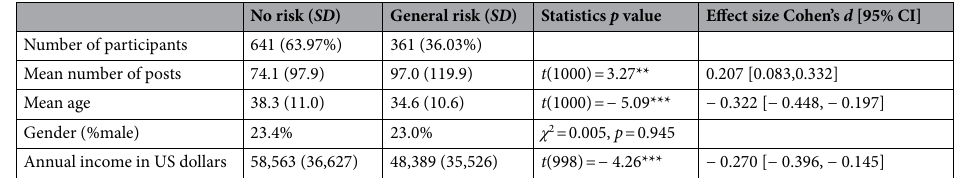
Table 2. Socio-demographic characteristics of users at general risk and of non-suicidal users ( N = 1002). No risk users who did not report of any suicidal ideation, General risk all the users who reported of at least